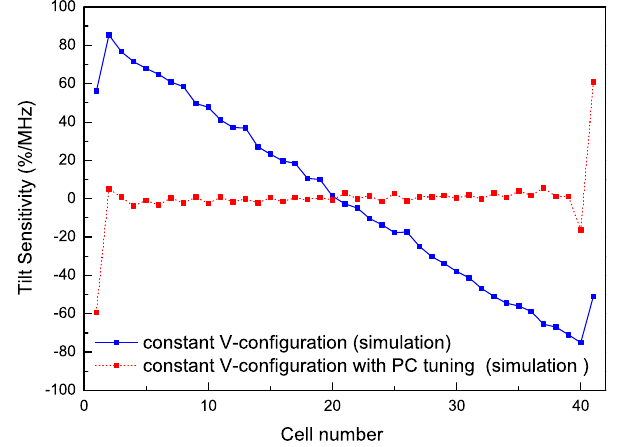
FIG. 13. Field tilt sensitivity of the constant V-configuration without post couplers (blue) and with post couplers